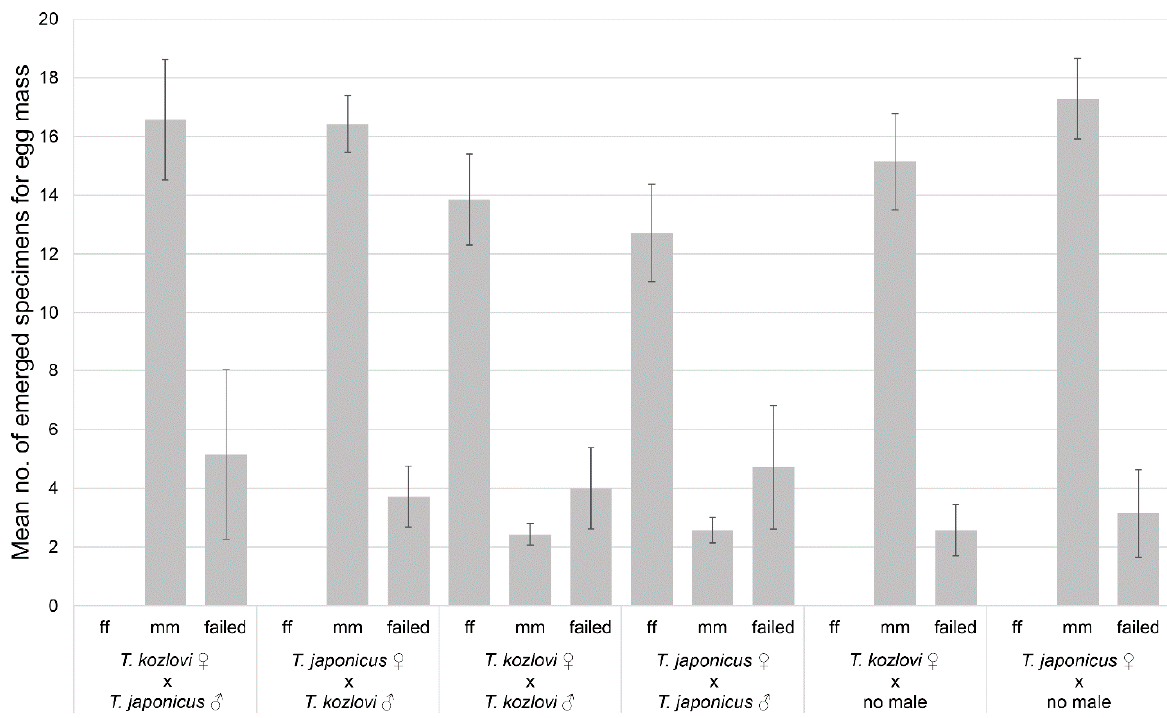
Figure 2. Mean numbers (± S.D.) of emerged females (ff) and males (mm) and unhatched eggs (failed) in each egg mass for the combinations: (1) T. kozlovi ♀ × T. japonicus ♂ ; (2) T. japonicus ♀ × T. kozlovi ♂ ; (3) T. kozlovi ♀ × ♂ ; (4) T. japonicus ♀ × ♂ ; (5) only T. kozlovi ♀ ; (6) only T. japonicus ♀ .